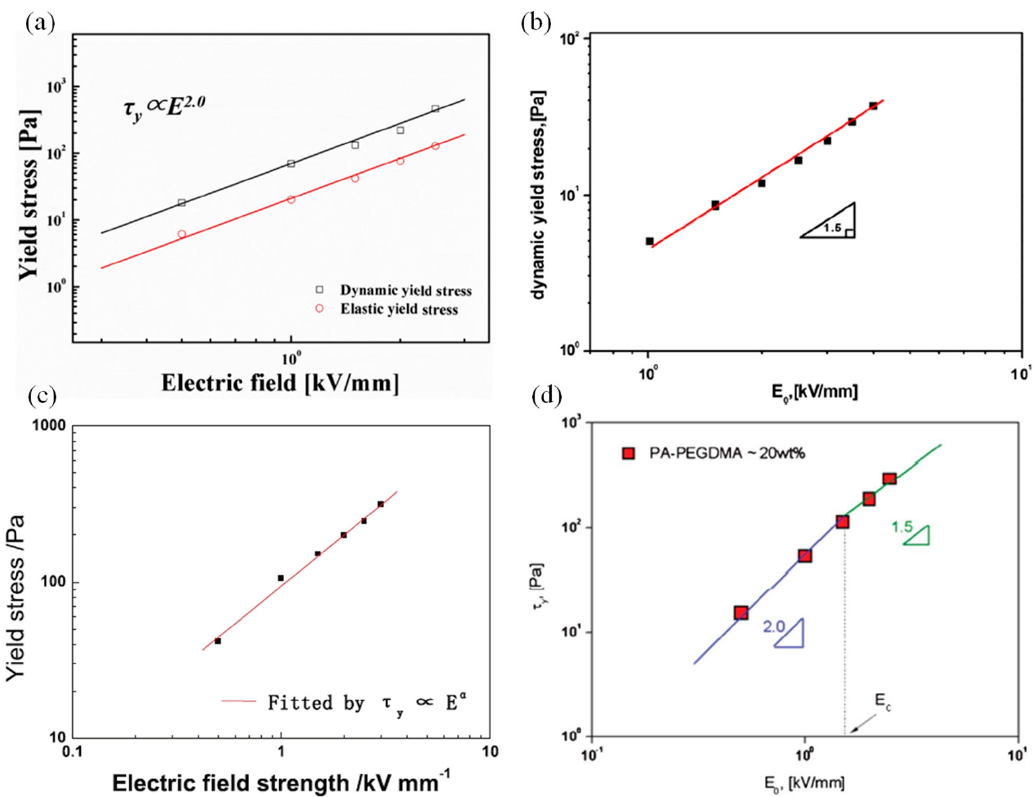
Figure 13. Yield stress versus electric field strength for ( a ) PS/PANI (Piao et al. [127], Copyright Elsevier, 2017); ( b ) PGMA/PANI (Zhang et al. [123], Copyright Elsevier, 2013); ( c ) Fe 2 O 3 /PANI (Tian et al.